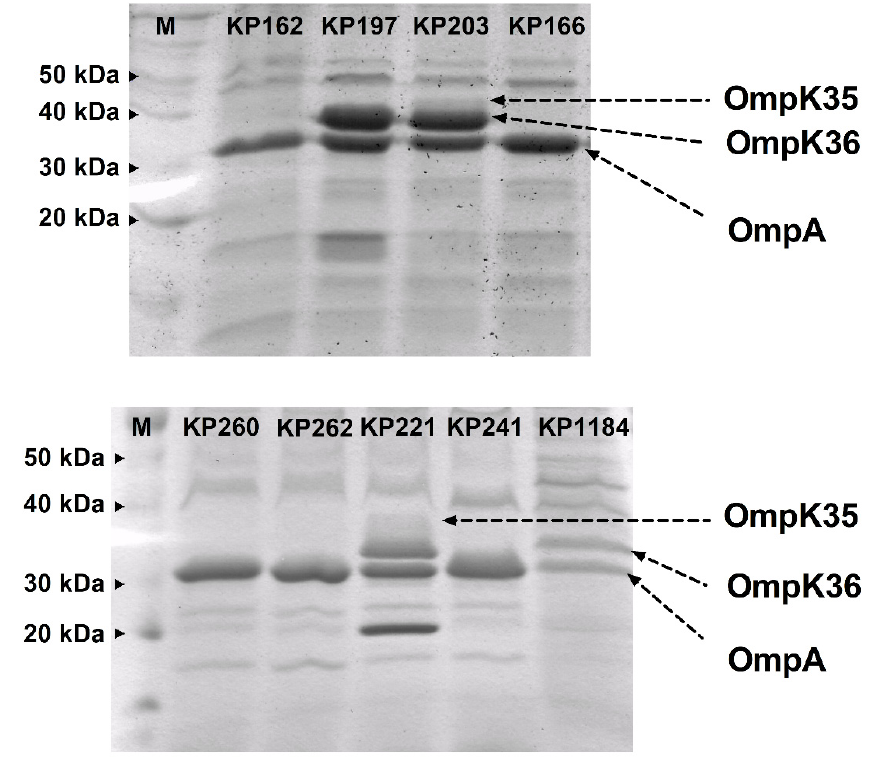
Figure 3. OMP profiles of nine OXA-48-producing K. pneumoniae isolates. OMP profiles were per- formed by SDS-PAGE. The arrow lines indicate OmpK35, OmpK36, and OmpA, respectively.